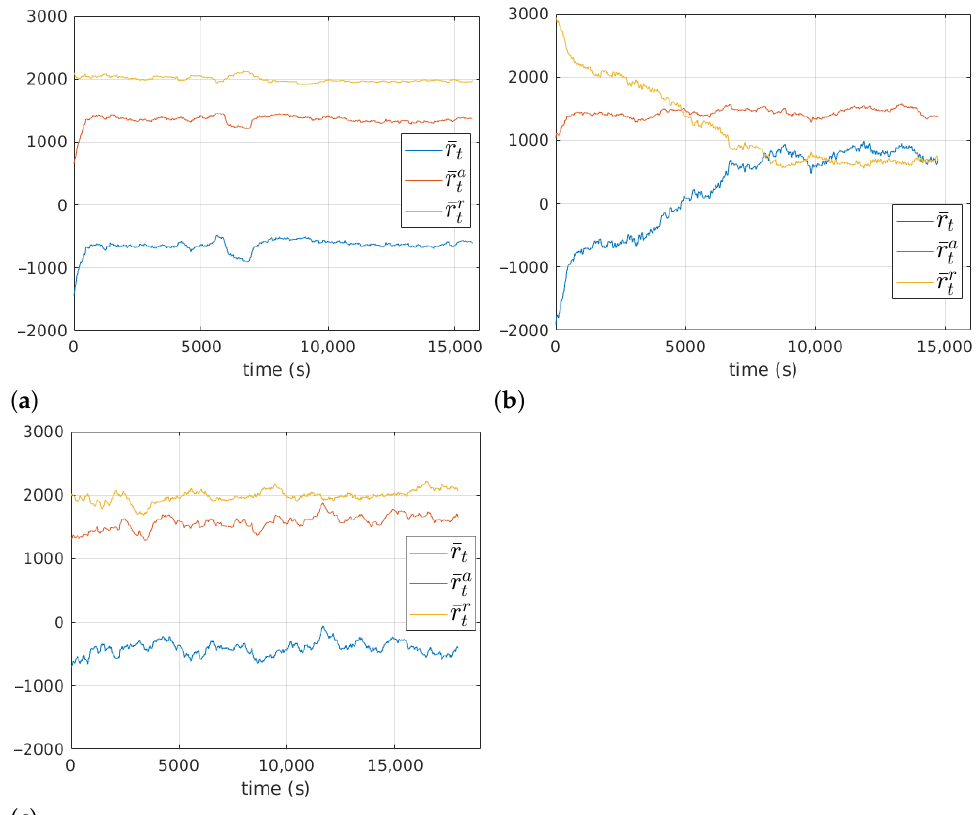
. In the second stage, t . The third stage t